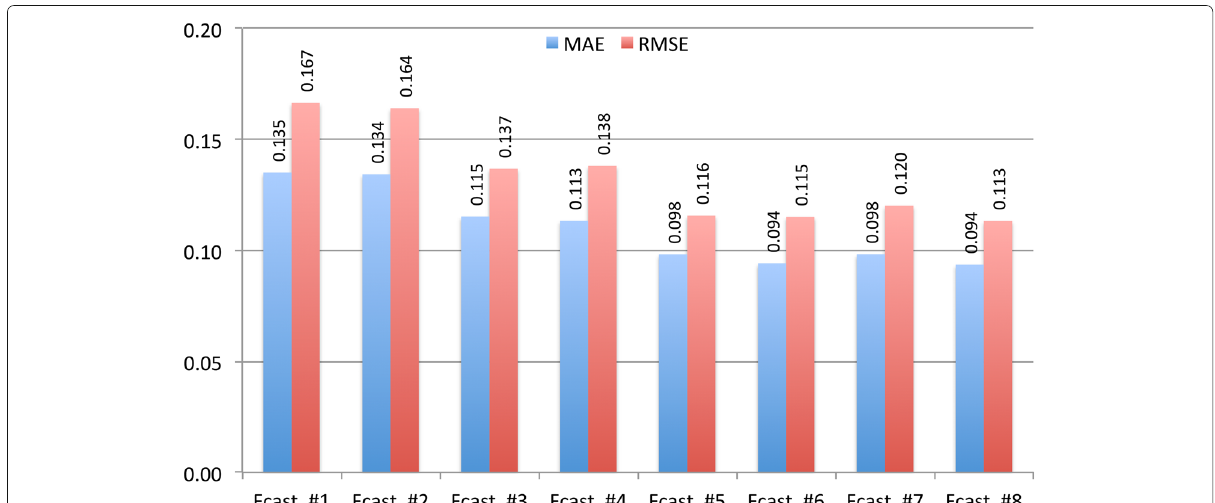
Fig. 6 Accuracy of different forecasting models (real prediction error for the forecasting period) This figure shows the accuracy of the different forecasting models for the 24 h test interval (forecasting horizon), where the MAE, MSE, and RMSE values represent the real prediction error of each forecasting model for this period. They are computed as the error between the data obtained by the forecasting model and the real data of the time series for the forecasting horizon